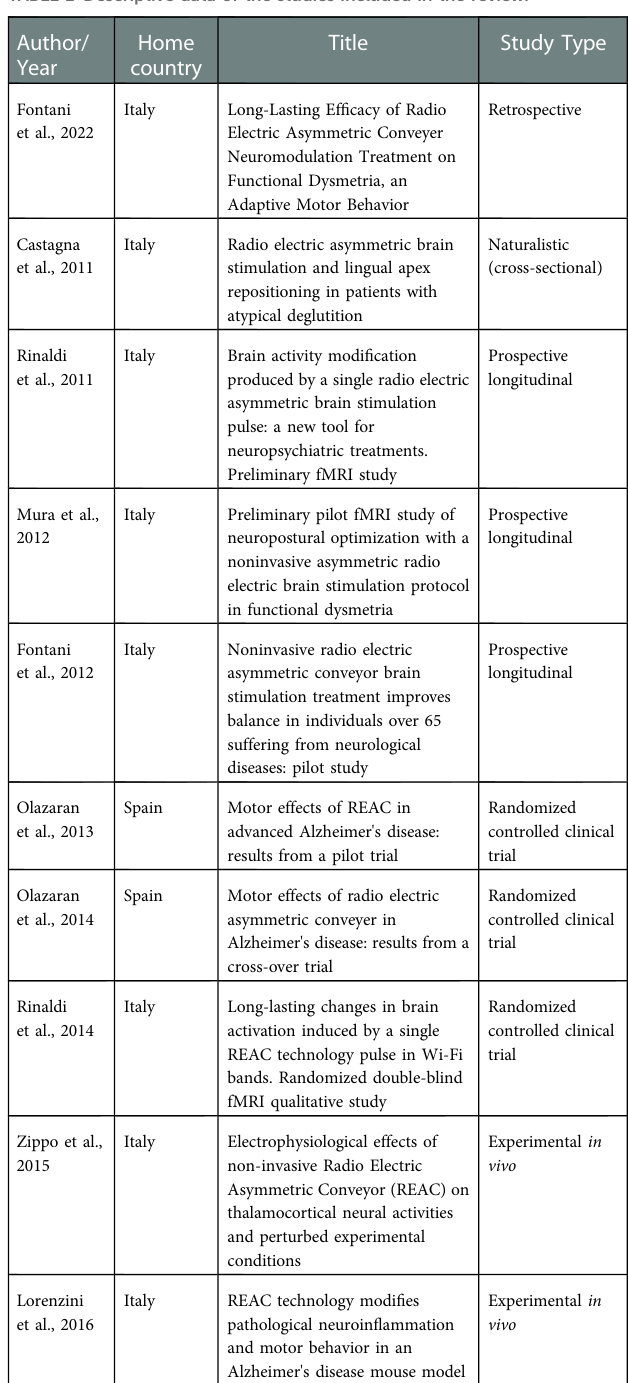
TABLE 1 Descriptive data of the studies included in the